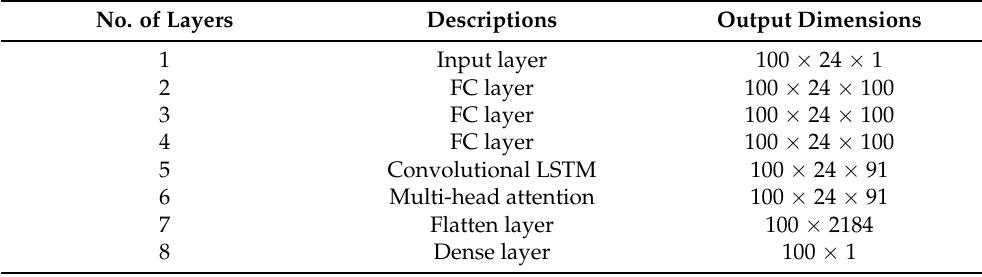
Table 3. The model architecture and hyperparameters used for the next 5th-hour traffic flow predic- tion task.